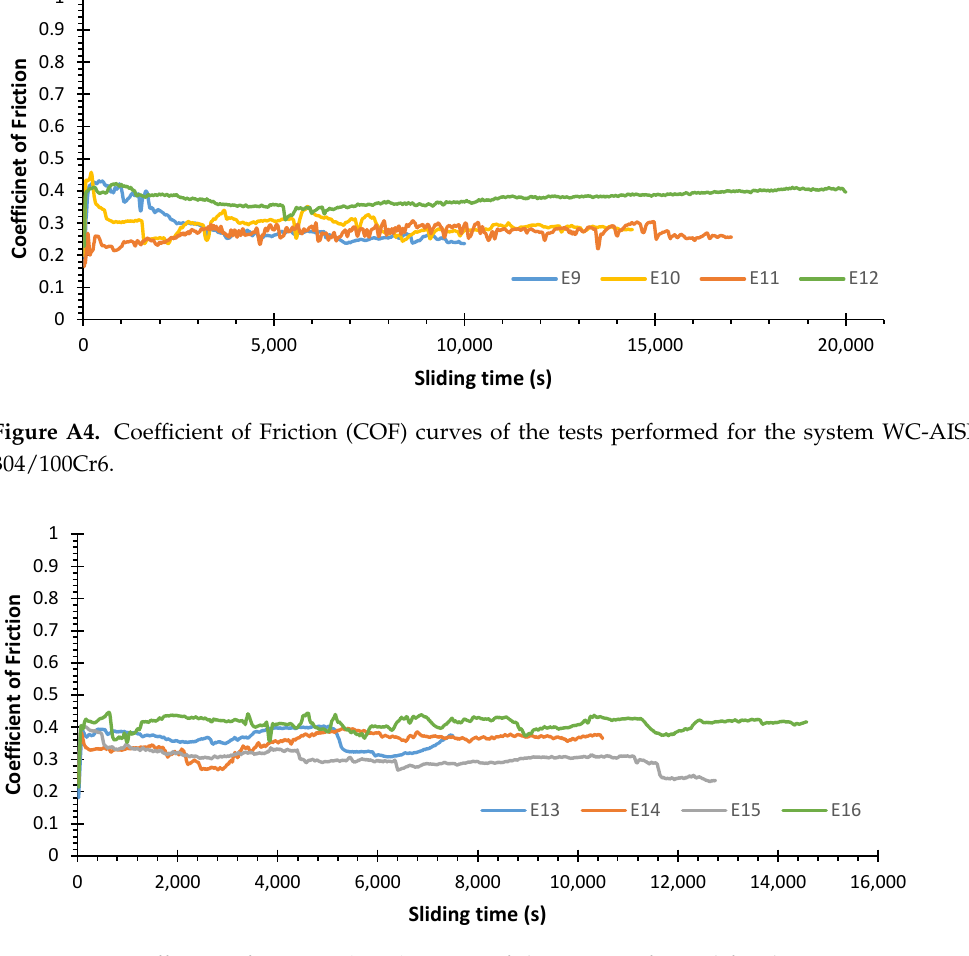
Figure A5. Coefficient of Friction (COF) curves of the tests performed for the system WC-AISI 304/Al 2 O 3 .